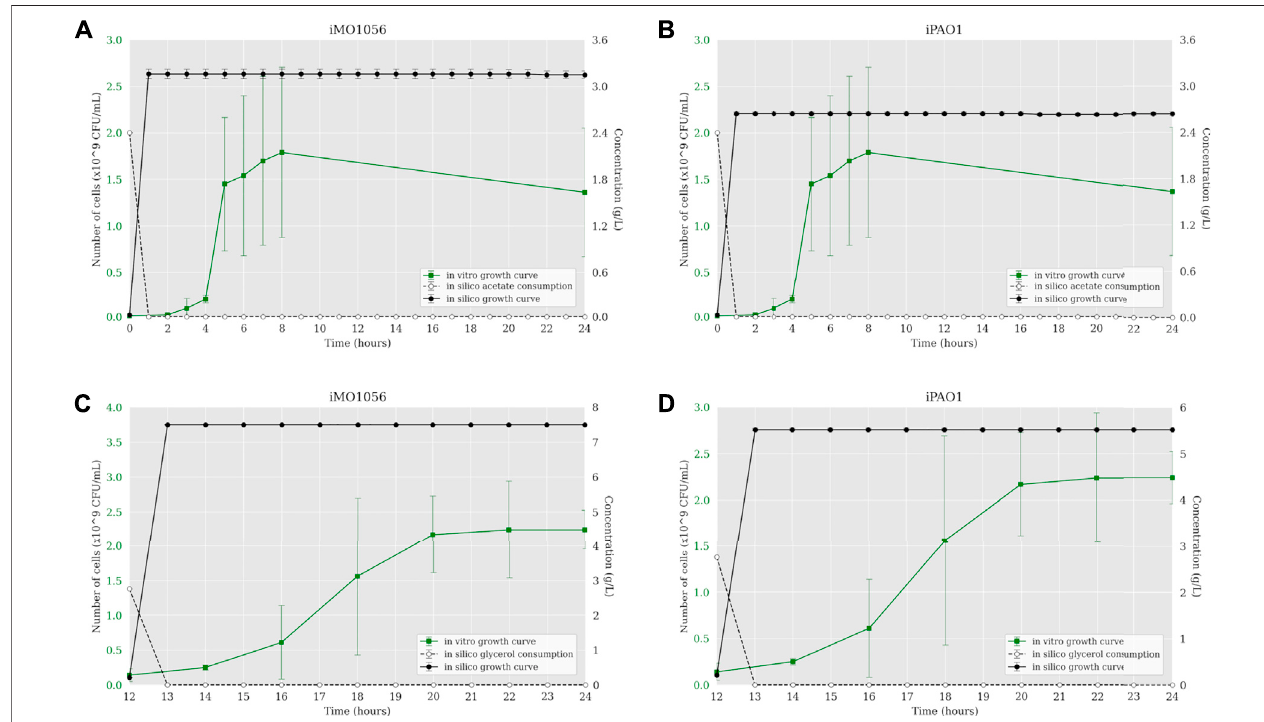
FIGURE1| Comparisonbetween P.aeruginosa growthcurvespredictedbyACBMfromthemetabolicmodelsandgrowthcurvesmeasuredbyDolanetal.(2020). (A,B) MOPS minimal medium with acetate as carbon source. (C,D) MOPS minimal medium with glycerol as carbon source. The graphics include the carbon source consumption over time (dashed lines). All measurements were made at least in triplicates, and curves represent the mean of all replicates. Error bars are the standard deviation of the